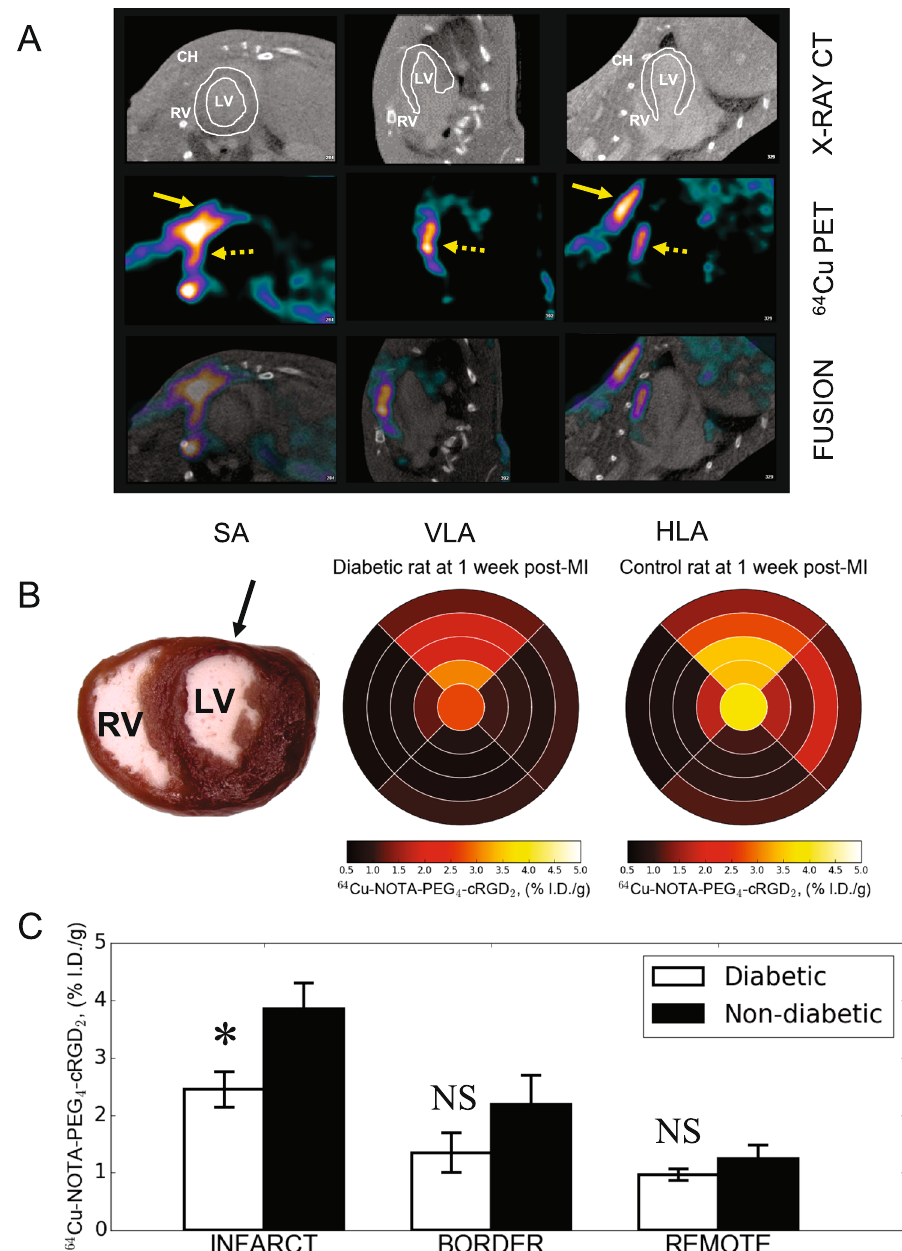
Figure 6. Representative in vivo hybrid PET-CT reconstructed short-axis (SA), vertical- (VLA) and horizontal long-axis (HLA) images acquired with iodinated contrast agent (Omnipaque) at 90 min post- injection of 64 Cu-NOTA-PEG 4 -cRGD 2 ( A ). The iodinated blood pool contrast agent permitted better definition of right (RV) and left ventricle (LV) within the myocardium which is contoured with solid white line. Focal uptake of 64 Cu-NOTA-PEG 4 -cRGD 2 was seen within anteriolateral LV regions (dashed yellow arrow) although significant uptake was seen in chest wall (CH) at the thoracotomy site (solid yellow arrows) indicating active wound healing associated α V β 3 receptor expression. Bull’s eye myocardial plots of 64 Cu- NOTA-PEG 4 -cRGD 2 activity in diabetic and non-diabetic Lewis rats subjected to surgical ligation of LAD to induce myocardial infarction (arrow) ( B ). Hearts were immediately excised at 120 min post-injection, cleaned and filled with inert dental molding material and cut in four 2-mm thick slices from apex to base. After removing right ventricle (RV), each left ventricular (LV) slice was cut in four segments (anterior, septal, posterior, lateral), and 64 Cu radioactivity was measured in each segment with gamma well counting. Data for each slice were expressed as percentage of injected dose per gram tissue (%I.D./g) and categorized as infarct, border and remote areas ( C